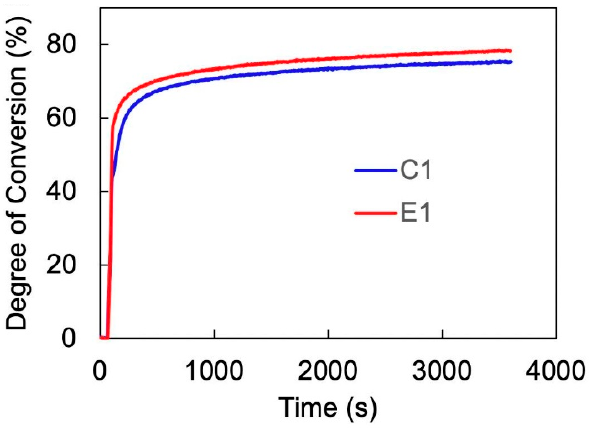
Figure 1. Real ‐ time in situ degree of conversion of C=C bond.